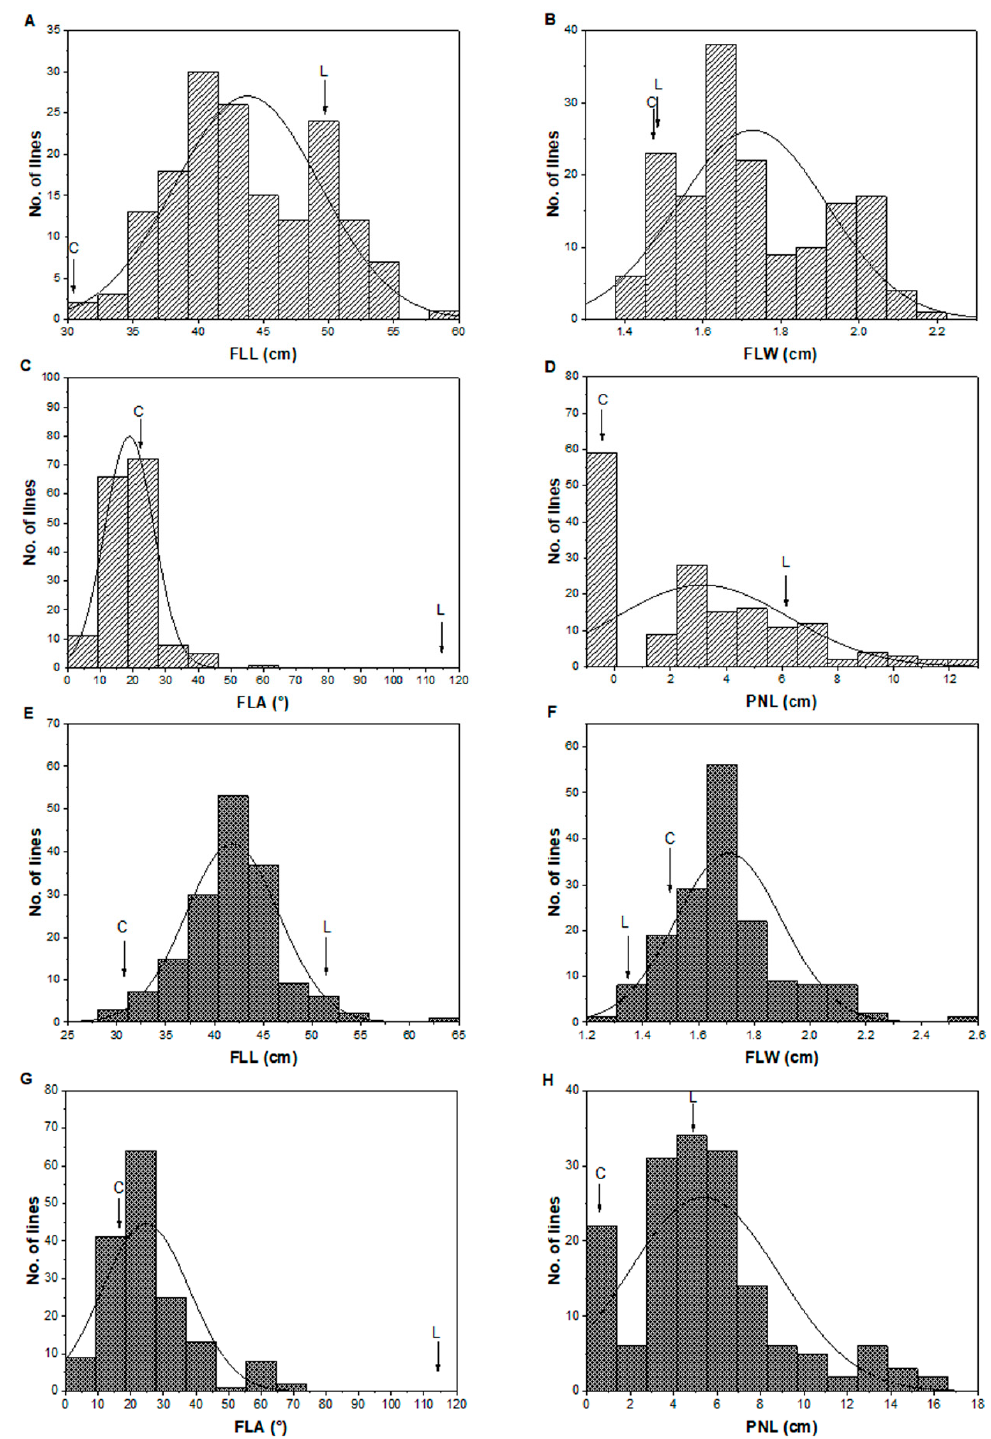
Figure 5. Frequency distribution of the four outcrossing traits in the CL-CSSL population in 2017 ( A – D ) and in 2018 ( E – H ). FLL, flag leaf length; FLW, flag leaf width; FLA, flag leaf angle; PNL, panicle neck length. C stands for the parent of ‘C-bao’, and L for ‘Ludao’. Significantly longer panicle neck lengths were recorded in Ludao, with a mean value of 6.4 cm, while C-bao had a mean value of 0.0 cm in 2017. In the CL-CSSL population, the PNL had a mean value of 5.1 cm, ranging from 0.0 to 12.0 cm, with a 60.8% of CV in 2017. Similar results were